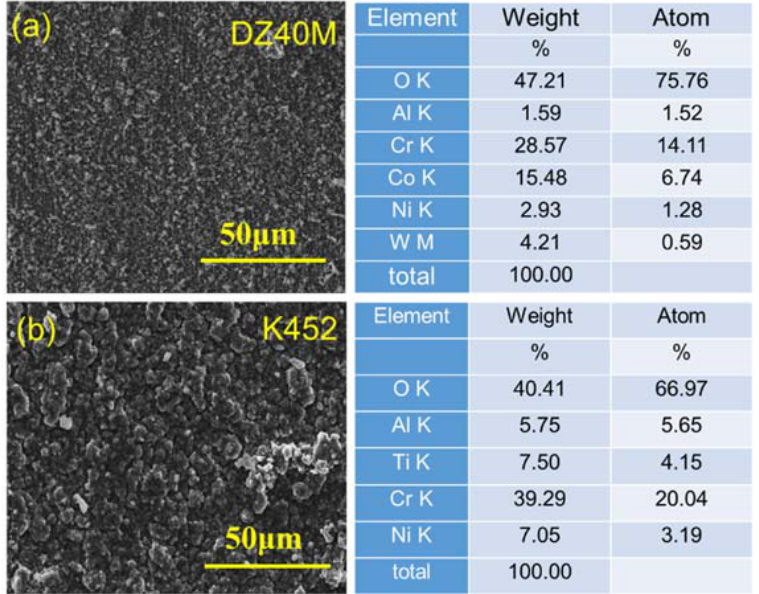
Figure 7. Surface morphology of DZ40M and K452 oxidized for 10 h and EDS. ( a ) DZ40M, ( b ) K452.